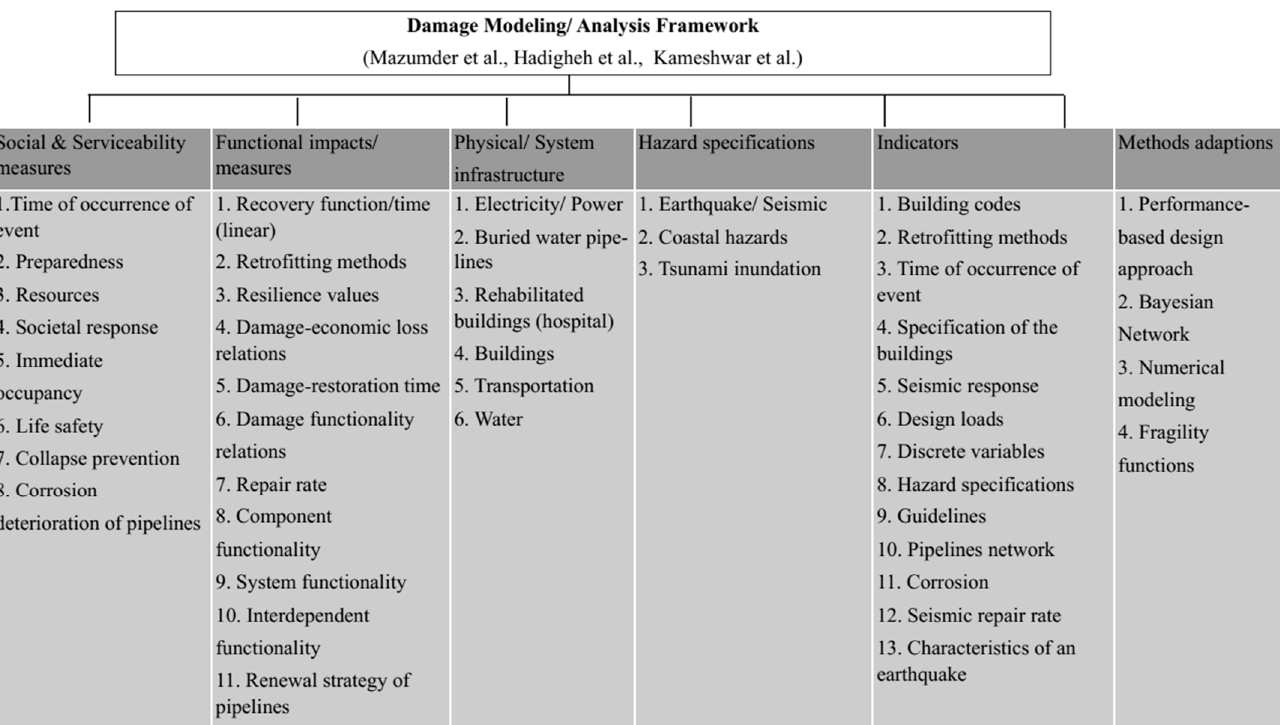
Figure 9. Attributes of the damage-analysis-based framework from past studies in terms of social, functional, and physical metrics, taking into account the indicators and methodology used.